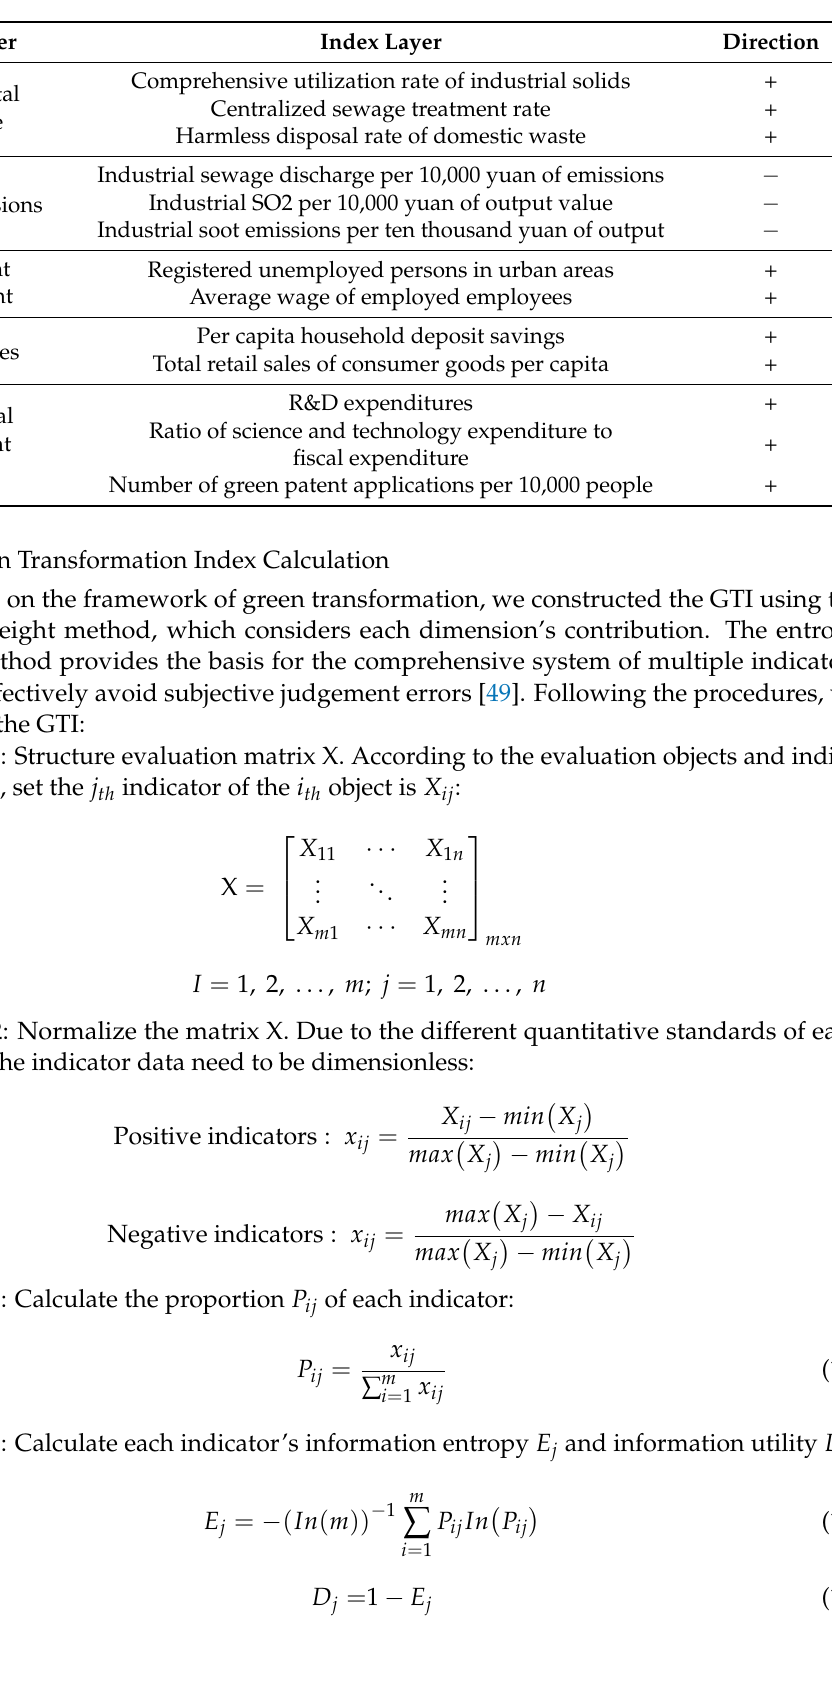
Table 3. Green transformation performance measurement indicator